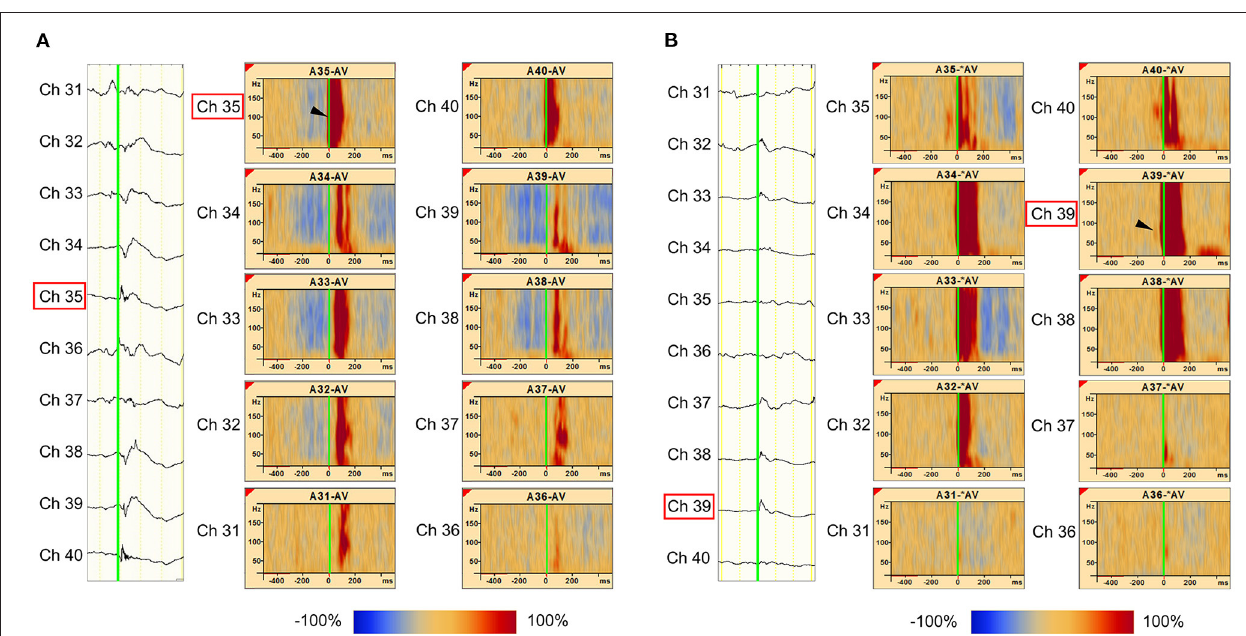
FIGURE 3 | Marked interictal spikes and spike-related ripples in Patient 1. Green lines on the rising edge of channel A35 (Ch 35) [negative spike ( A , left)] and channel A39 (Ch 39) [negative spikes ( B , left)] are shown. The time–frequency plots in the square show the augmentation of ripples related to Ch 35 spikes ( A , right) and Ch 39 spikes ( B , right). Augmentation of ripples ranges from − 100% (blue) to 100% (red) relative to the reference period ( − 500 to − 300ms). In the middle column of Ch 35 spike-related ripples (A) , the red bands from Ch 35 to Ch 31 show a progressively longer latency, which indicates propagation of ripples across these channels. The shortest latency of the Ch 35 spikes-related ripple augmentation channel (ripple onset) was visually estimated as Ch 35 ( A , arrowhead), and the Ch 39 spikes-related ripple augmentation channel (ripple onset) was estimated as Ch 39 ( B ,